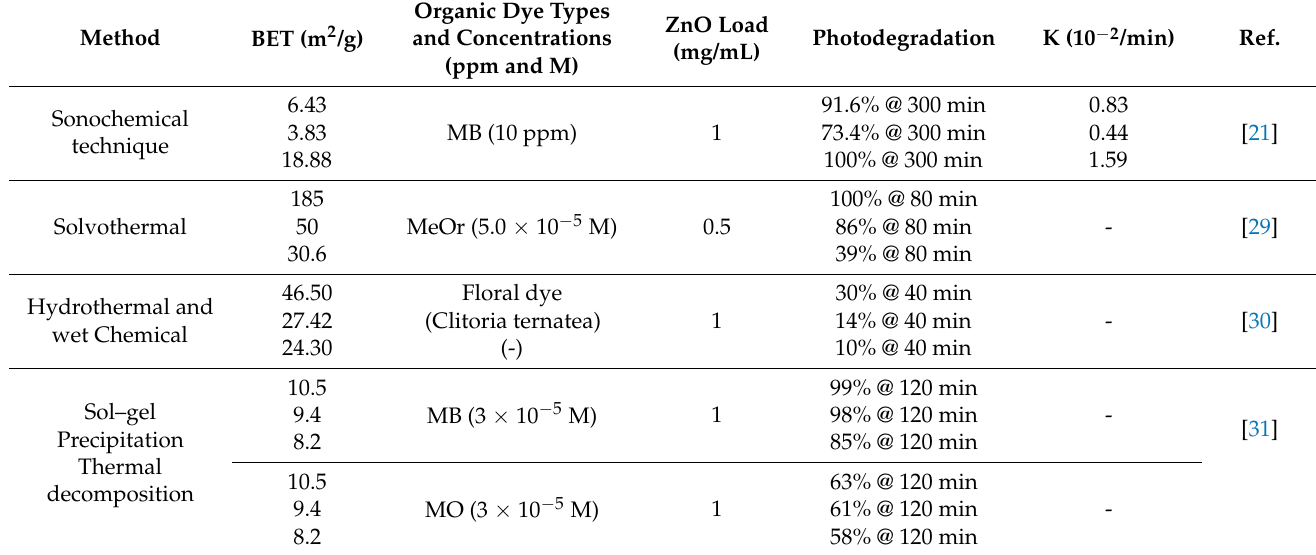
Table 1. Some reports on the relationship between the specific surface area and photocatalytic